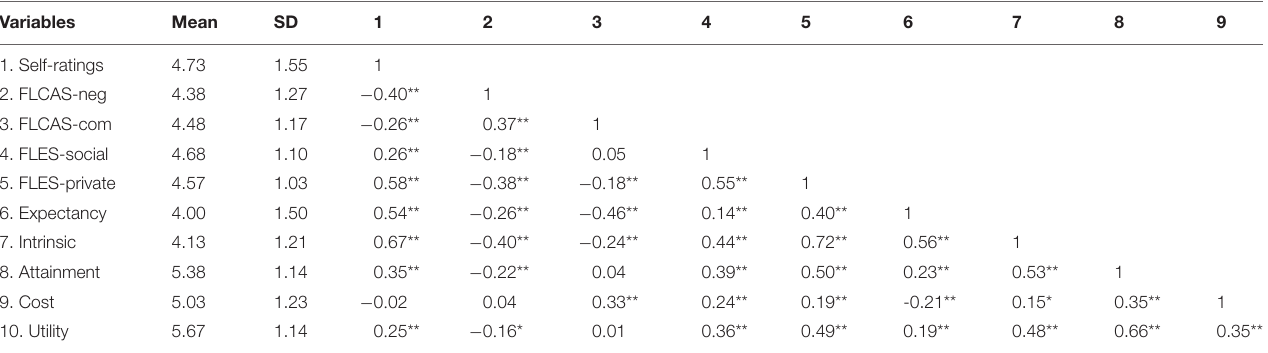
TABLE 3 | Summary of means, standard deviation, and correlations among main variables. Variables